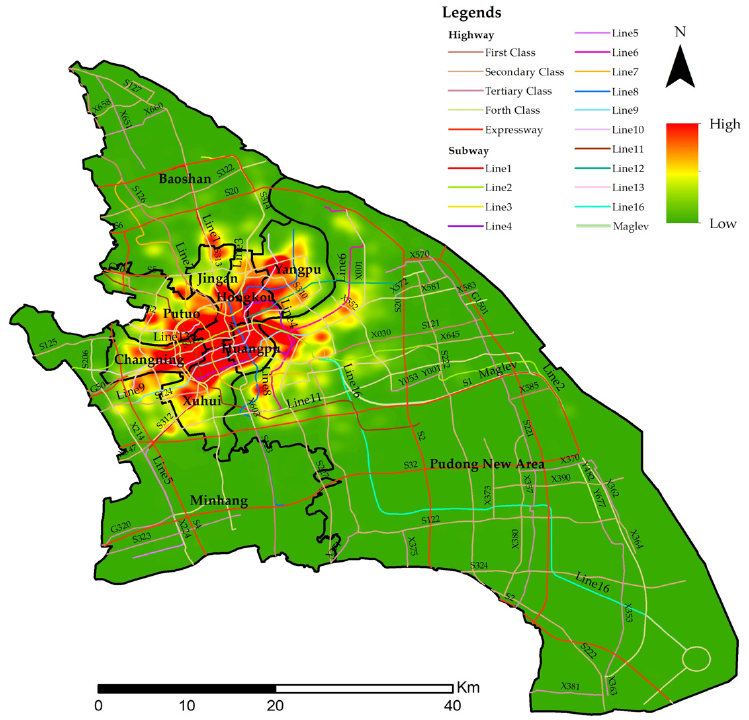
Figure 14. Check ‐ in density of females.